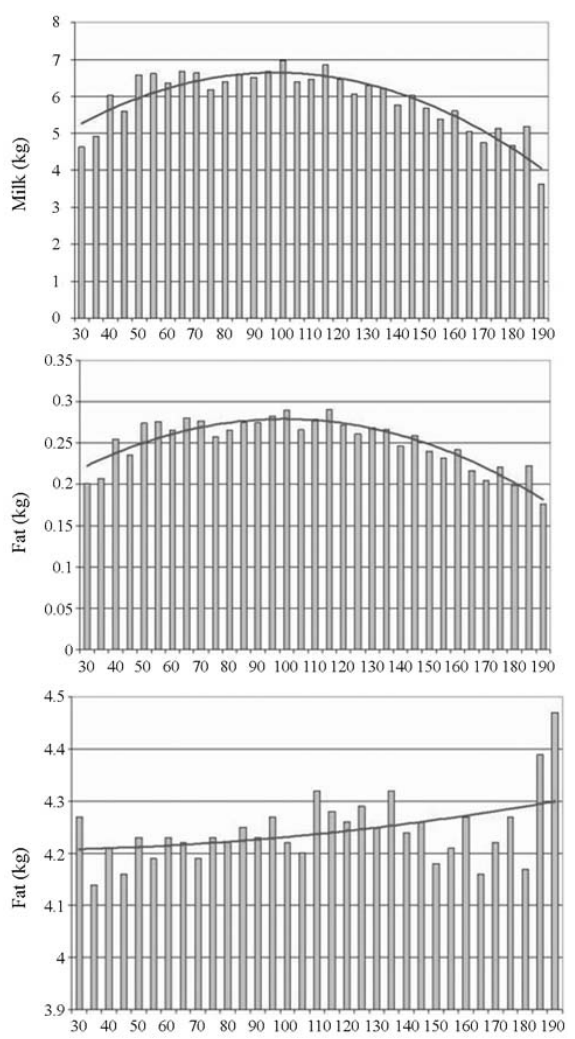
Figure 4 - Effects of age at calving (months) on milk yield (MY), fat yield (FY) and fat percentage (FP) of crossbred Holstein-Zebu cows.